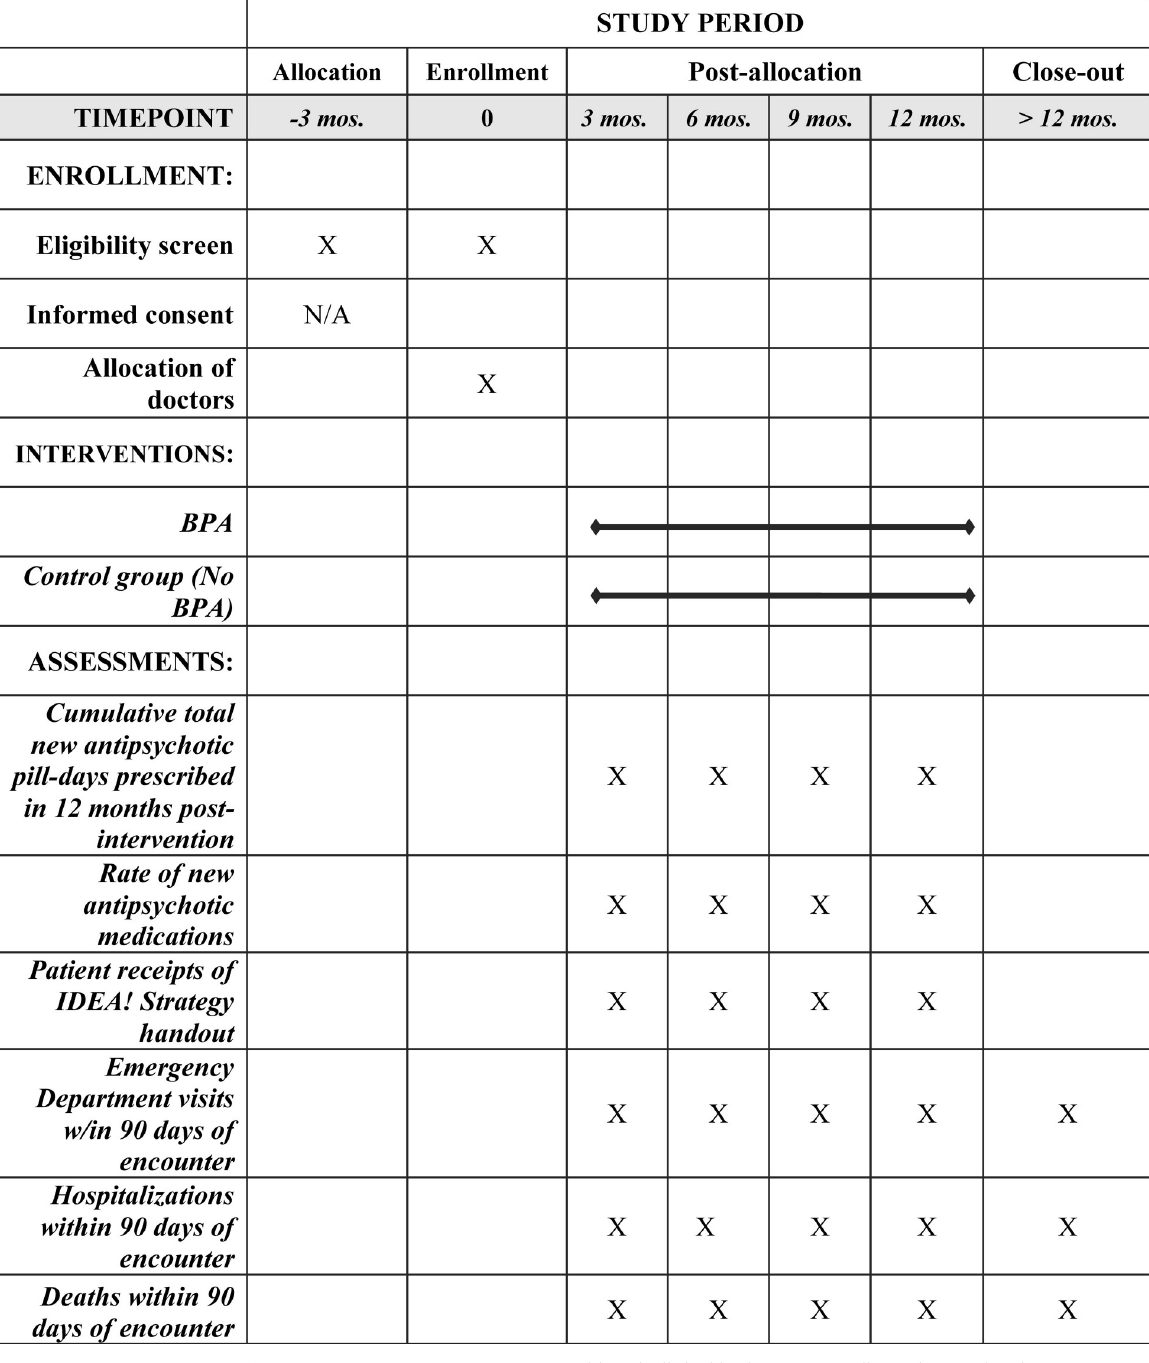
Fig 1. SPIRIT Schedule of enrollment, interventions, and assessments. Although all eligible physicians are allocated into either the intervention or control groups, physicians are only enrolled in the trial once they prescribe a new antipsychotic medication to an eligible patient, which could occur at any point within the 12-month study period. Hospitalizations include psychiatric